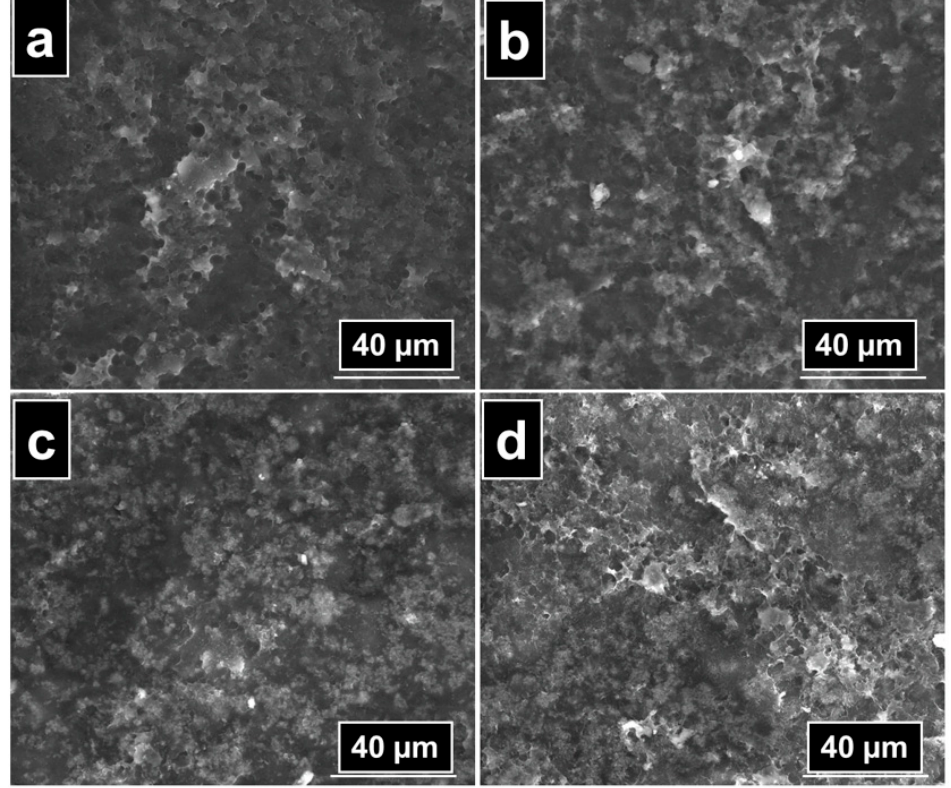
Figure 6. SEM images of PVA/CS-0 ( a ), PVA/CS-1 ( b ), PVA/CS-2 ( c ), and PVA/CS-3 ( d ) composite films.